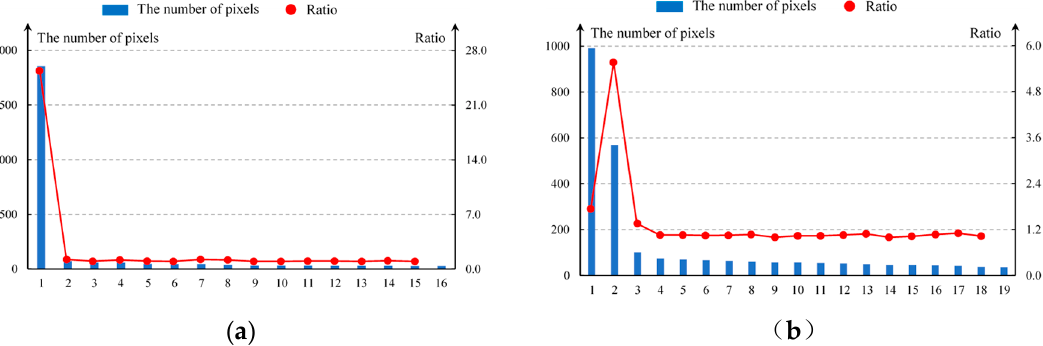
Figure 8. The number of pixels inside contours and the ratio of the number of pixels inside previous contour to that inside next contour: ( a ) The result of Figure 7d; ( b ) the result of Figure 7h.